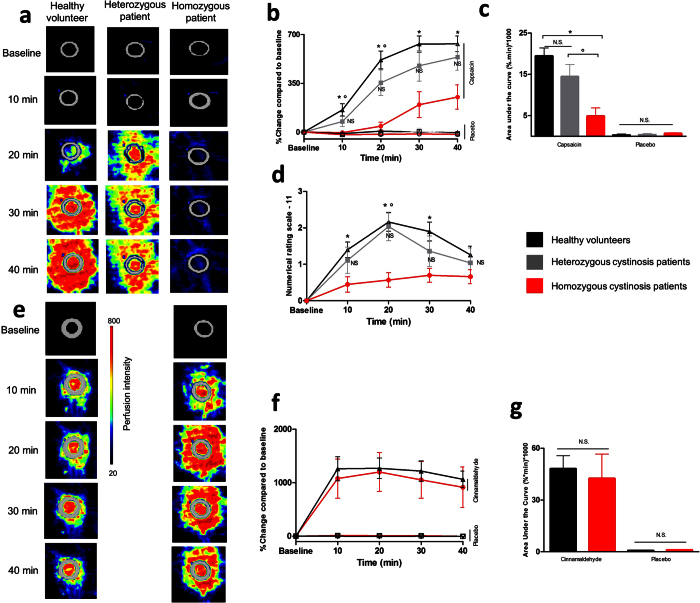
Sensitivity of cystinosis patients to topical application of capsaicin or cinnamaldehyde.(a) LDI images showing responses to topical capsaicin application in a healthy volunteer and in a heterozygous and a homozygous cystinosis patient. (b) Mean time course of the DBF expressed as % change from baseline in response to capsaicin or placebo (=vehicle), in healthy volunteers (n = 25), heterozygous patients (n = 14) and homozygous patients (n = 11). (c) Mean area under the curve for the data in (b). (d) Capsaicin induced pain, expressed in NRS-11 over time for the subjects in (b). (e) LDI images showing responses to topical cinnamaldehyde application in a healthy volunteer and in a homozygous cystinosis patient. (f) Mean time course of the DBF expressed as % change from baseline in response to cinnamaldehyde or vehicle, in healthy volunteers (n = 5) and homozygous patients (n = 5). (g) Mean area under the curve for the data in (f). *p < 0.05 between homozygous patients and healthy volunteers. °p < 0.05 between homozygous patients and heterozygous patients (Kruskall-Wallis with post-hoc Dunn’s (capsaicin) or Mann-Whitney-U (cinnamaldehyde)) N.S.: Non-significance. Data are presented as mean ± SEM.